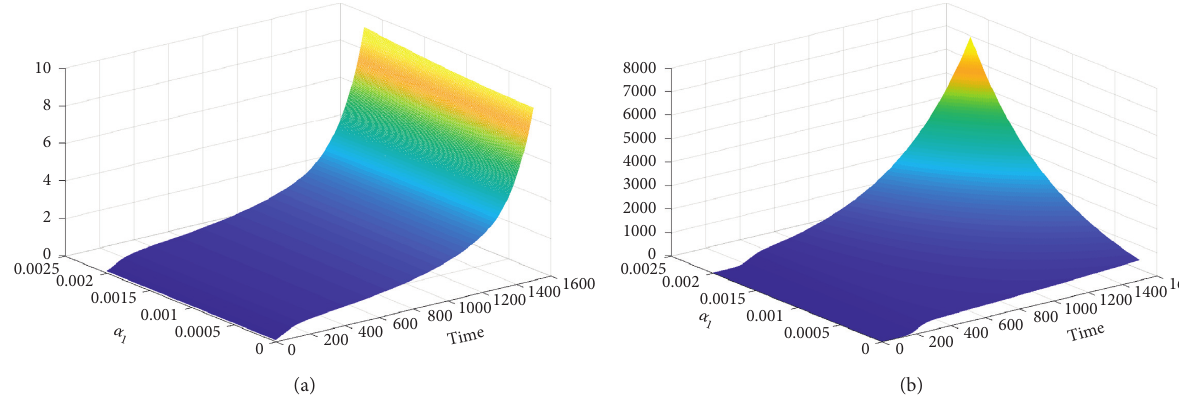
Figure 7: Amount of the information as a function of time and α